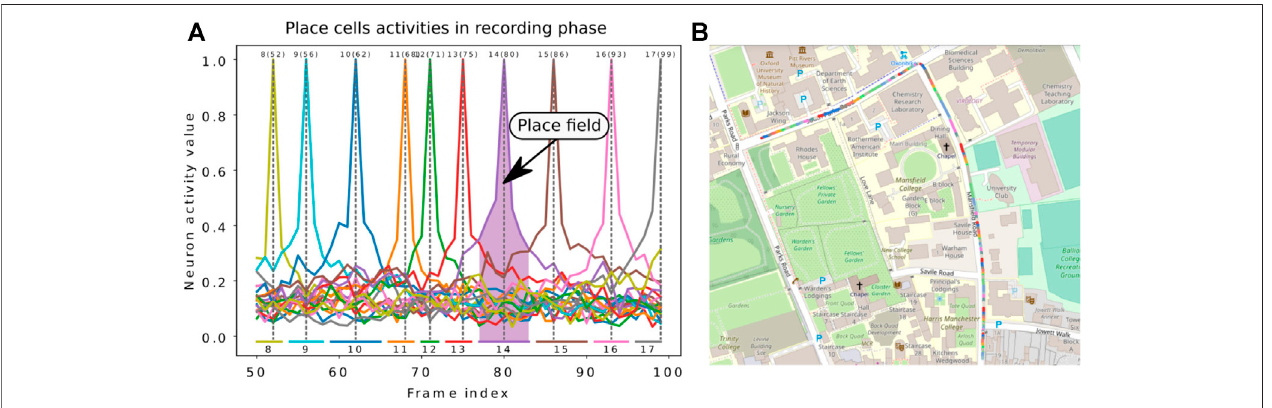
FIGURE 7 | Illustration of the Log-Polar Max-Pi (LPMP) + Vig problem. (A) The left image presents the neural activity of the winner memory layer, generated during therecordingstep.Duringthisphase,nolearningoccurredinordertorecordwhichcellshouldrespondtoagivenposition.Thus,the graydottedlines indicatetheframe index at whichlearning occurredforeach neuron, the numbers ontop denote theindexofneurons, andthe numbersinbrackets indicatetheindex ofthecorresponding imagein thesequence.The colored horizontal bars indicate the spaces encoded by each neuron. (B) The second image shows amap representing onerecording of the Oxford car dataset with the learned places. Each colored line represents the space computed via the replay-learn evaluation (RLE) method, according to (A) .